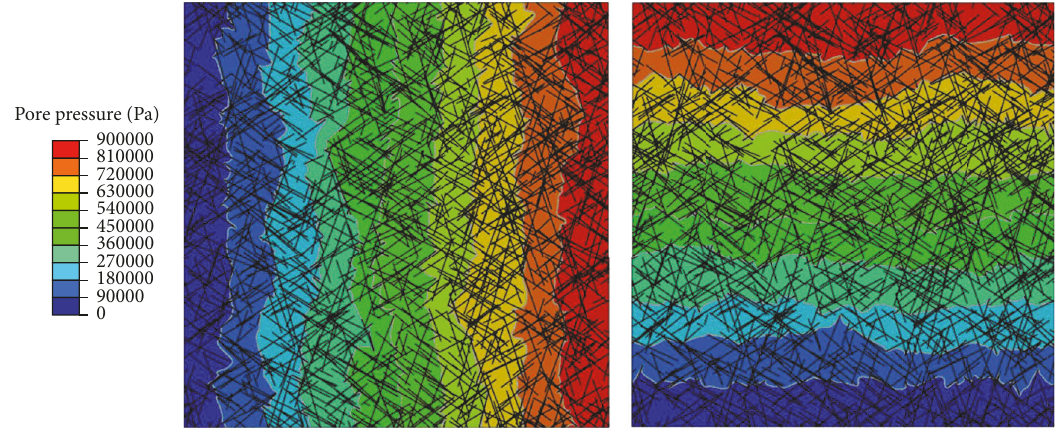
Figure 20: The pore pressure field at the side length of 9 m and the rotation angle of 0 ∘ .